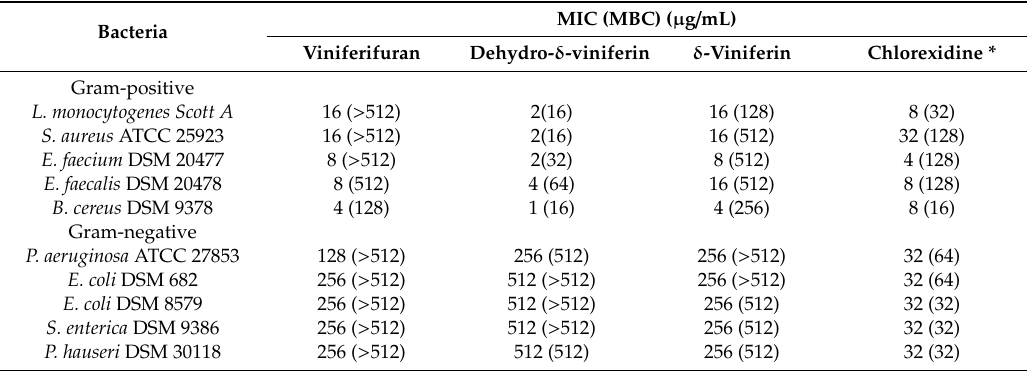
Table 17. MIC and MBC (in brackets) of resveratrol dimers against a panel of bacteria from Mattio et al. (2019)